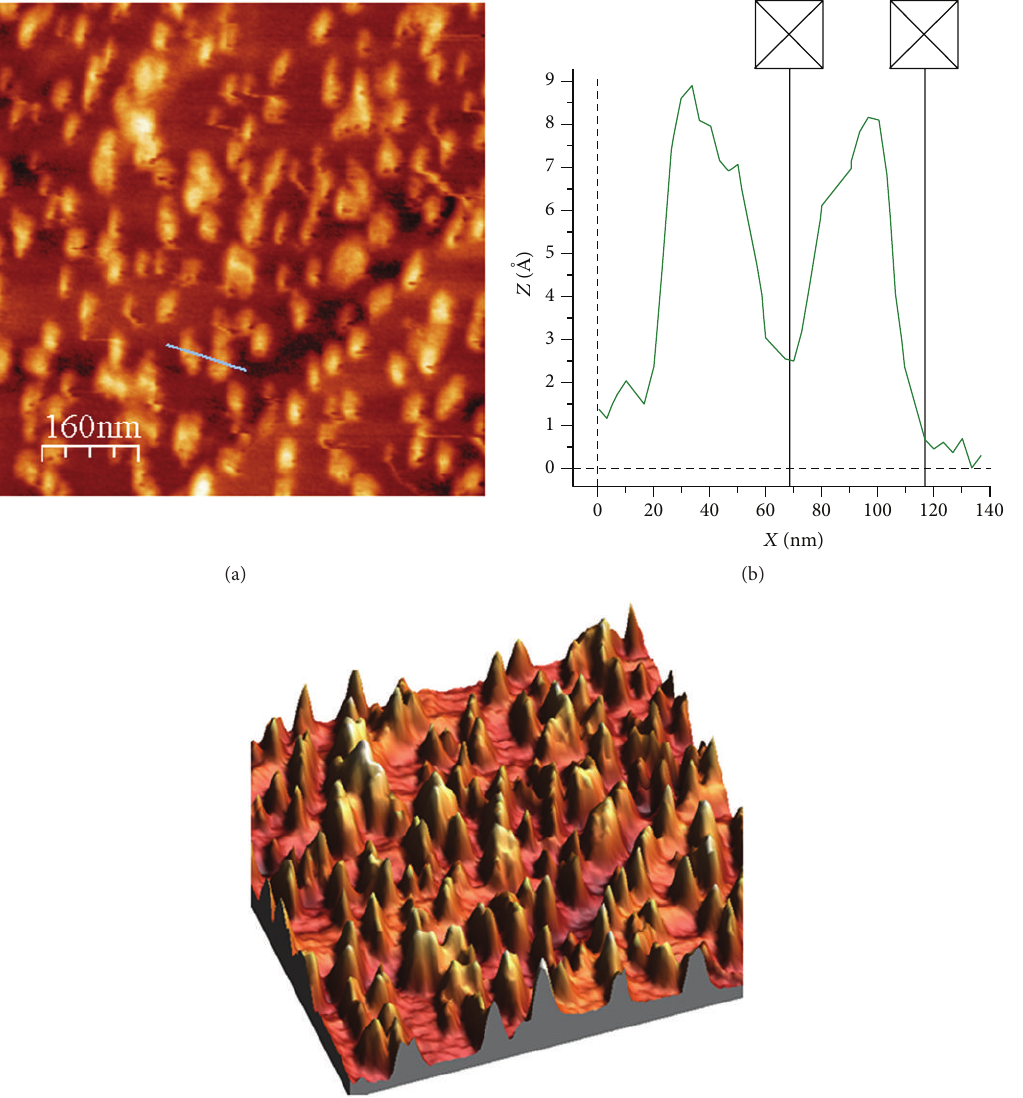
Figure 3: Water solution of fullerenol/benzalkonium chloride nanocomposite: large-scale image, 810 × 810nm 2 (a); corresponding cross section with two nanoparticles, 50 nm and 48nm, and maximal peaks for the nanocomposite, 9 nm and 8 nm (b); 3D image of nanocomposite on the HOPG surface